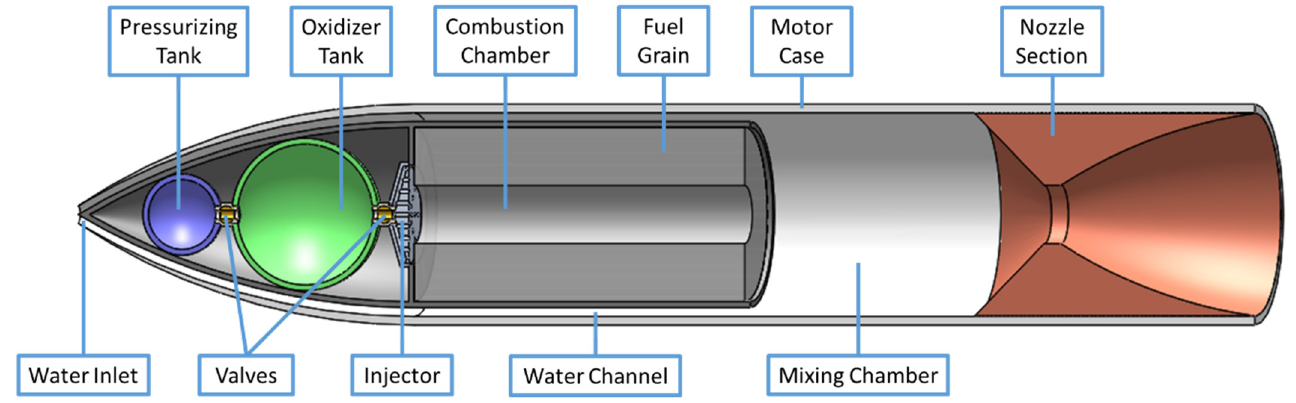
Figure 1. Schematic illustration of a hybrid, water-breathing ram-rocket (figure adapted from [16]).